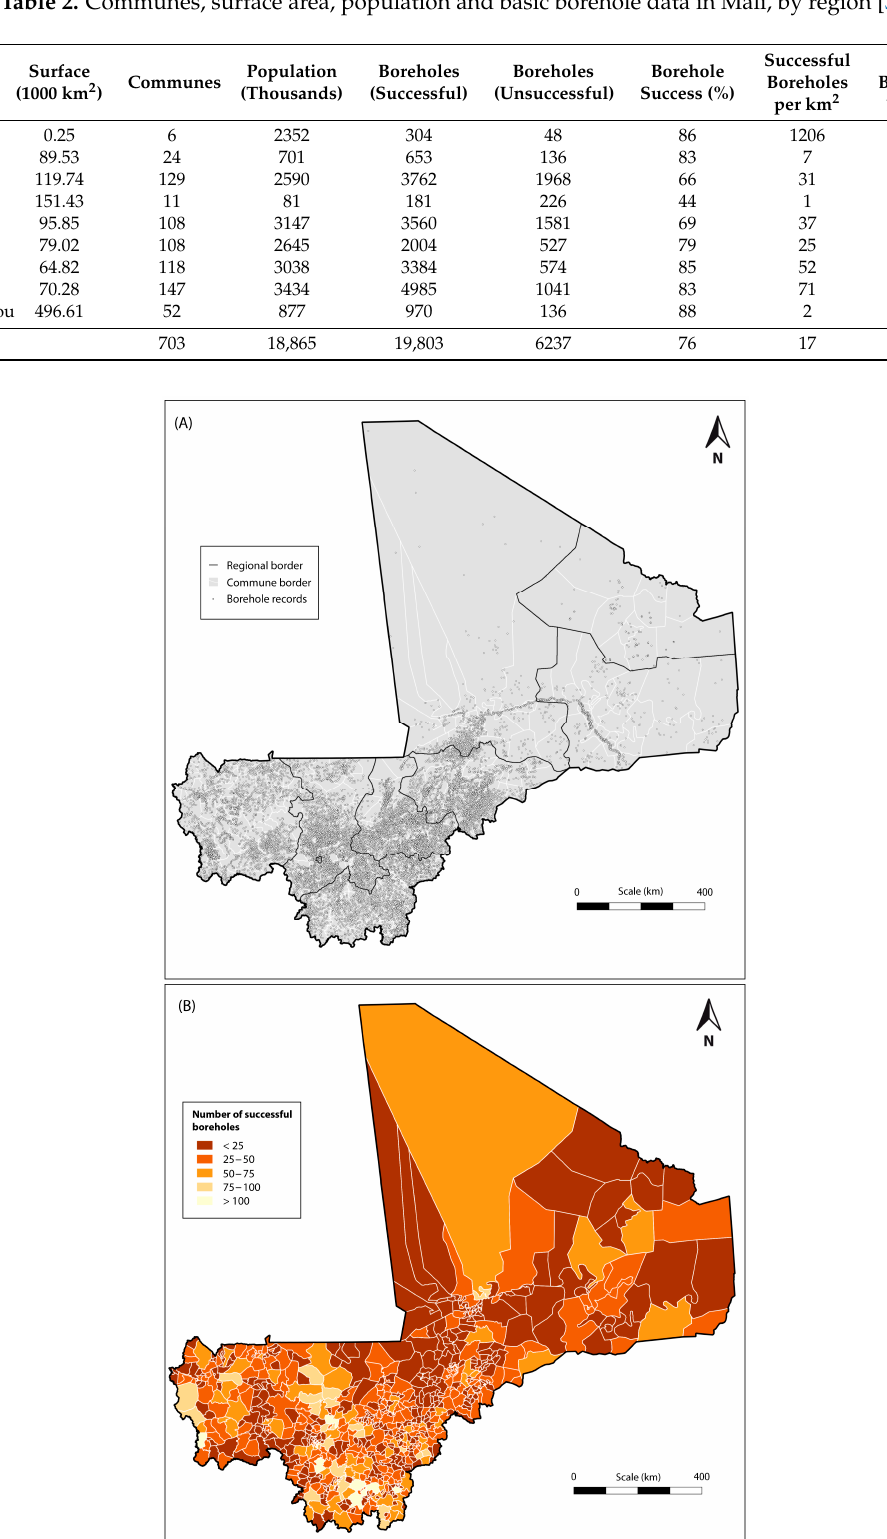
Figure 4. ( A ) Human settlements where borehole data are available (dark dots represent human settlements where boreholes have been reported); ( B ) Number of successful boreholes per commune.